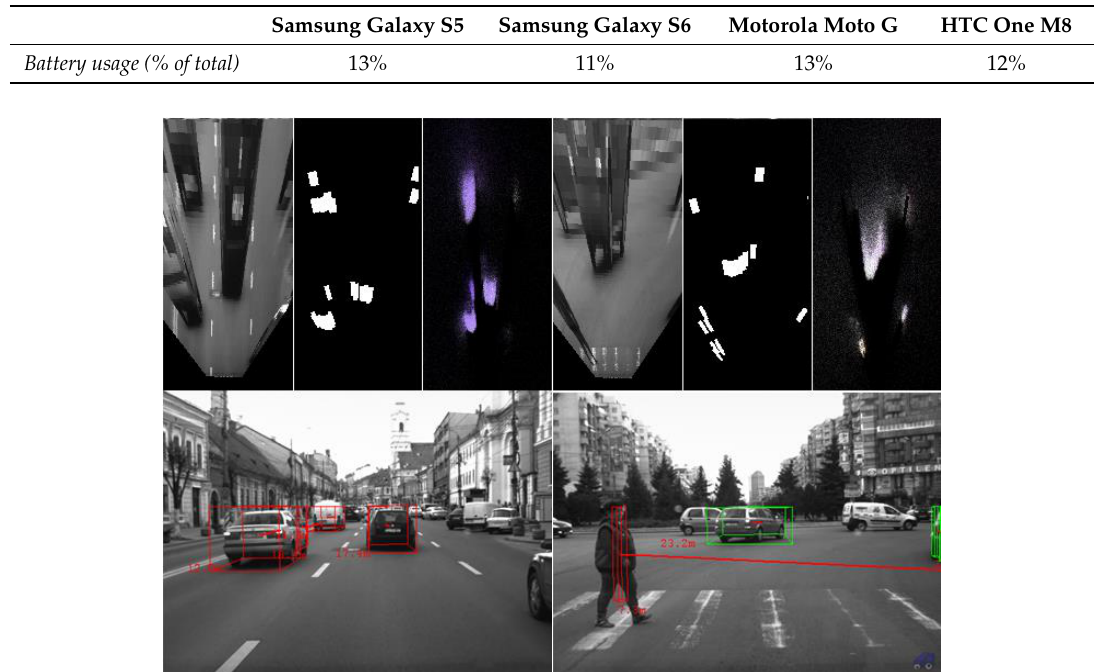
Table 3. Battery drain on a 20 min test run.